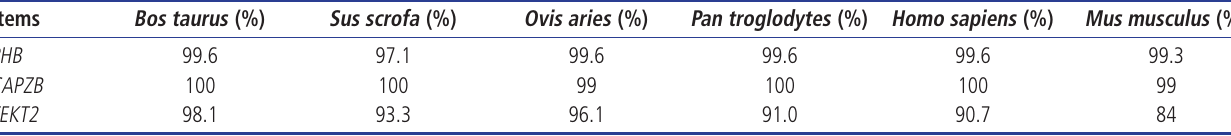
Table 3. The homologous analysis of Murrah buffalo PHB, CAPZB, and TEKT2 amino acid sequences